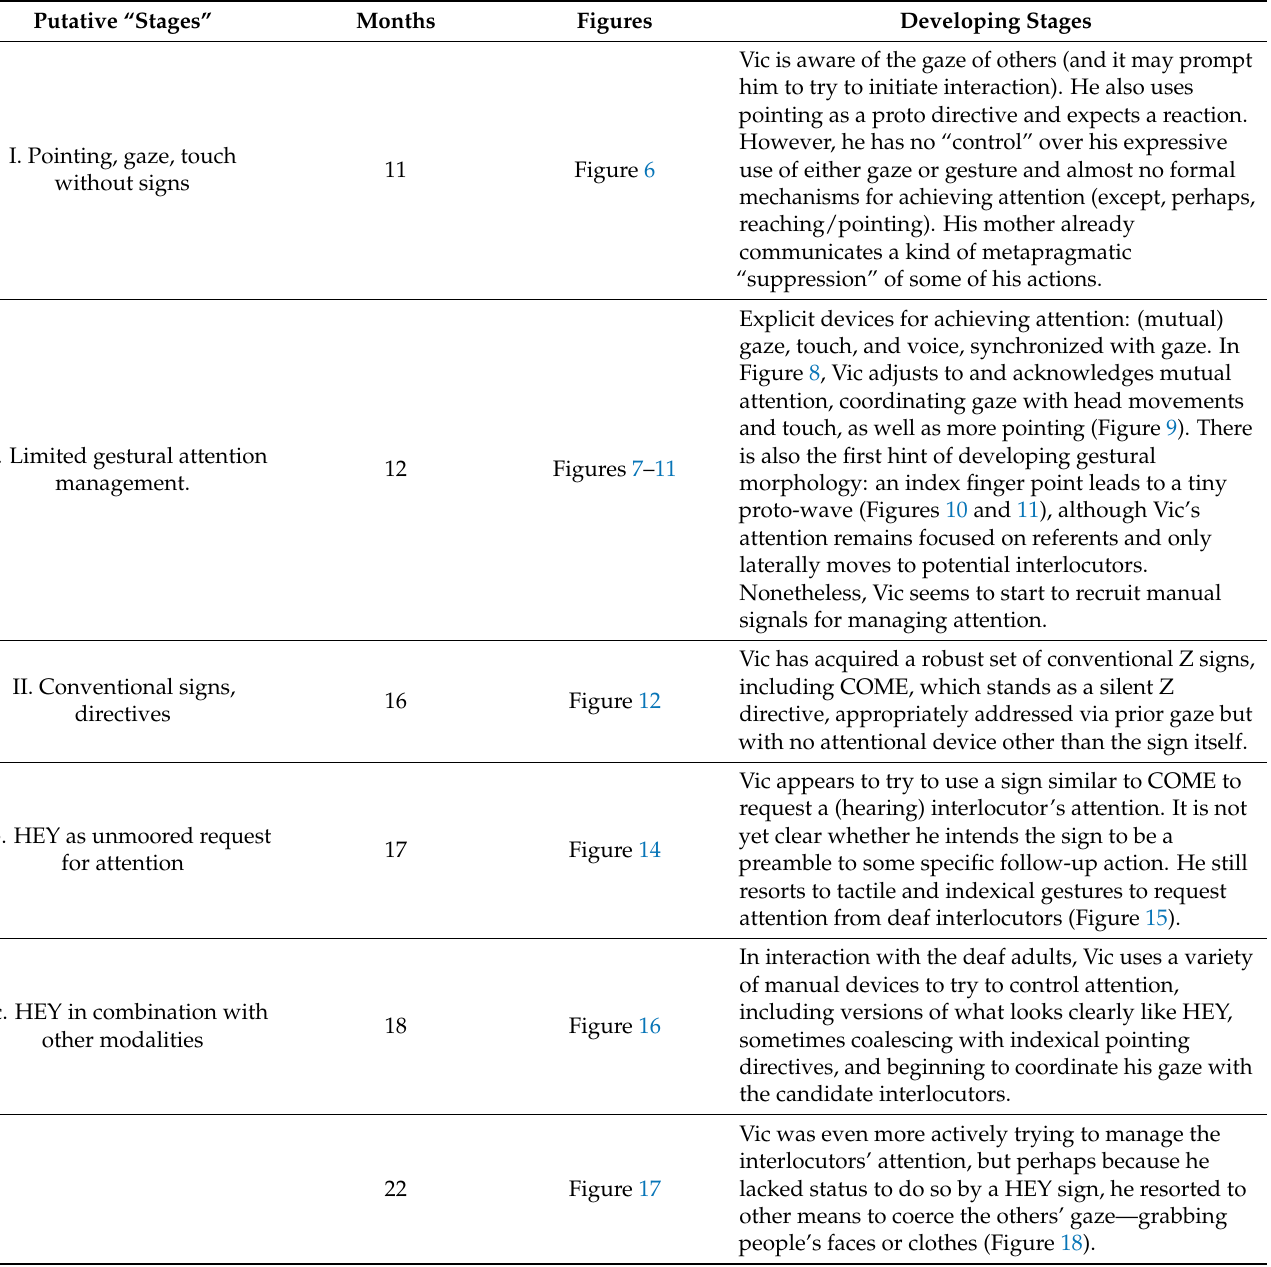
Table 2. Hypothesized stages in Vic’s acquisition of HEY1 and